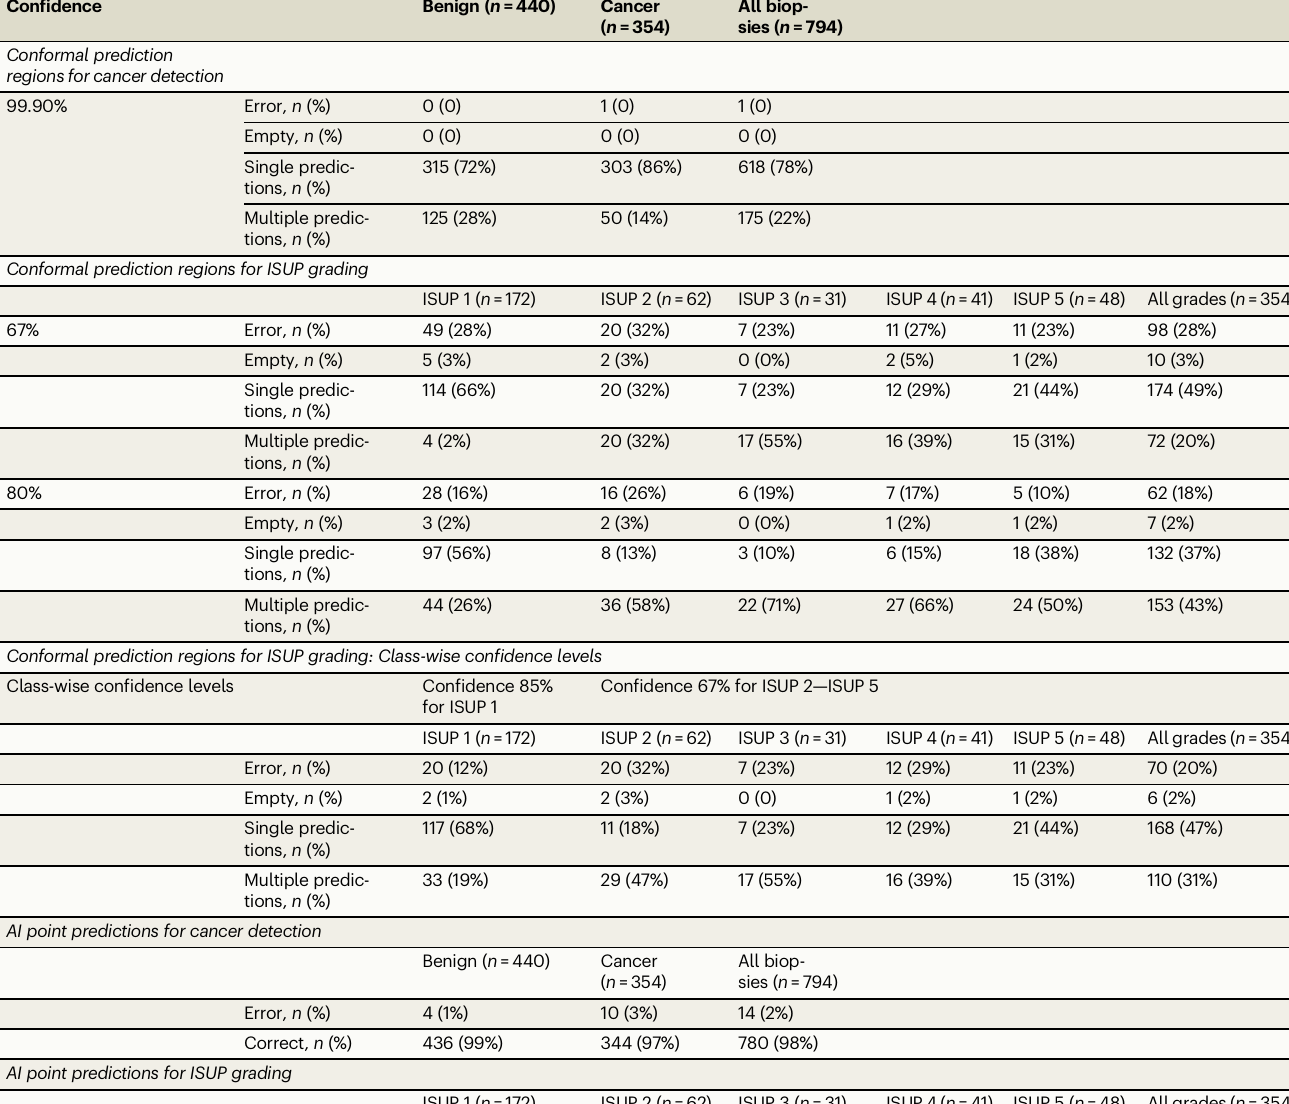
Table 2 | Prediction regions on the baseline cases (Test set 1) for cancer detection and ISUP grading, n (%) Con fi